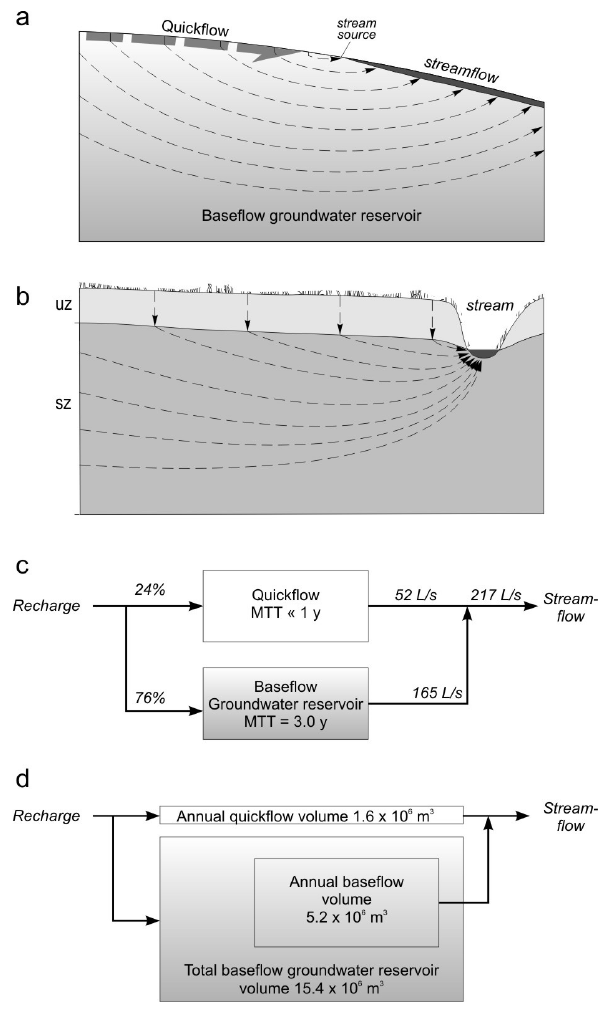
Fig. 9. Conceptual flow model (a) parallel to the stream, (b) per- Figure 9. Conceptual flow model a) parallel to the stream, b) perpendicular to the stream, UZ-5 pendicular to the stream, UZ-unsaturated zone, SZ-saturated zone, unsaturated zone, SZ-saturated zone, c) fractions of quickflow and baseflow, and d) 6 (c) fractions of quickflow and baseflow, and (d) comparison of wa- ter volumes, with the size of the boxes proportional to the volume comparison of water volumes, with the size of the boxes proportional to the volume of the 7 of the various various volumes. 8